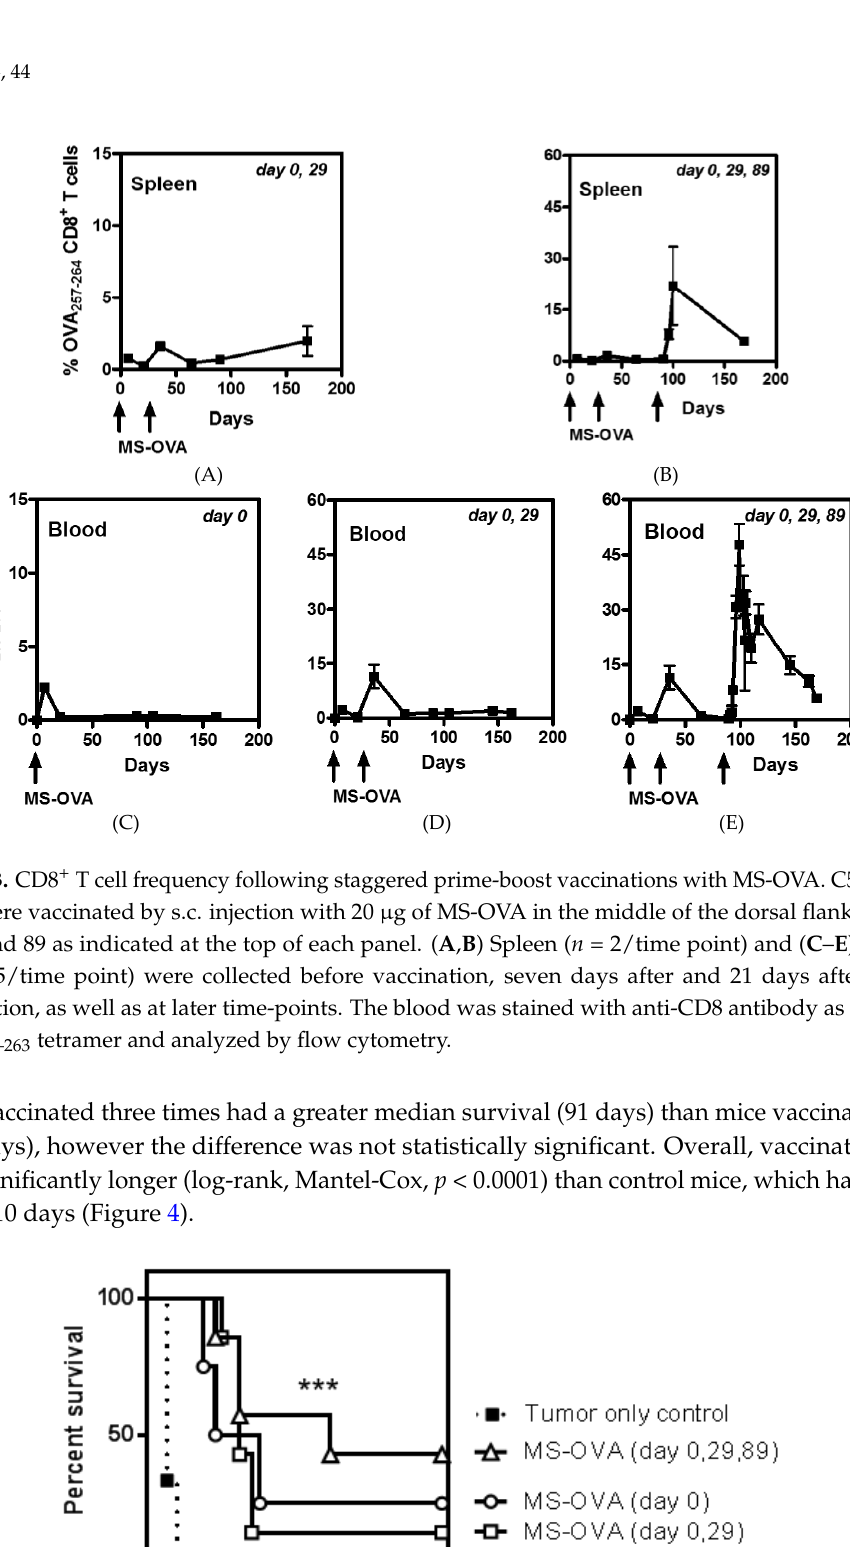
Figure 4. Tumor challenge following staggered prime-boost vaccinations with MS-OVA. C56BL/6 mice were vaccinated by s.c. injection with 20 µg of MS-OVA in the middle of the dorsal flank at day 0, 29, and 89 as indicated in the legend. Two hundred sixteen days after initial vaccination 10 6 B16- OVA cells were injected s.c. in the lower dorsal flank. Survival was measured over time. *** All vaccinated animals survived significantly longer than control p < 0.0001, log-rank (Mantel-Cox) Test. n = 3–7.